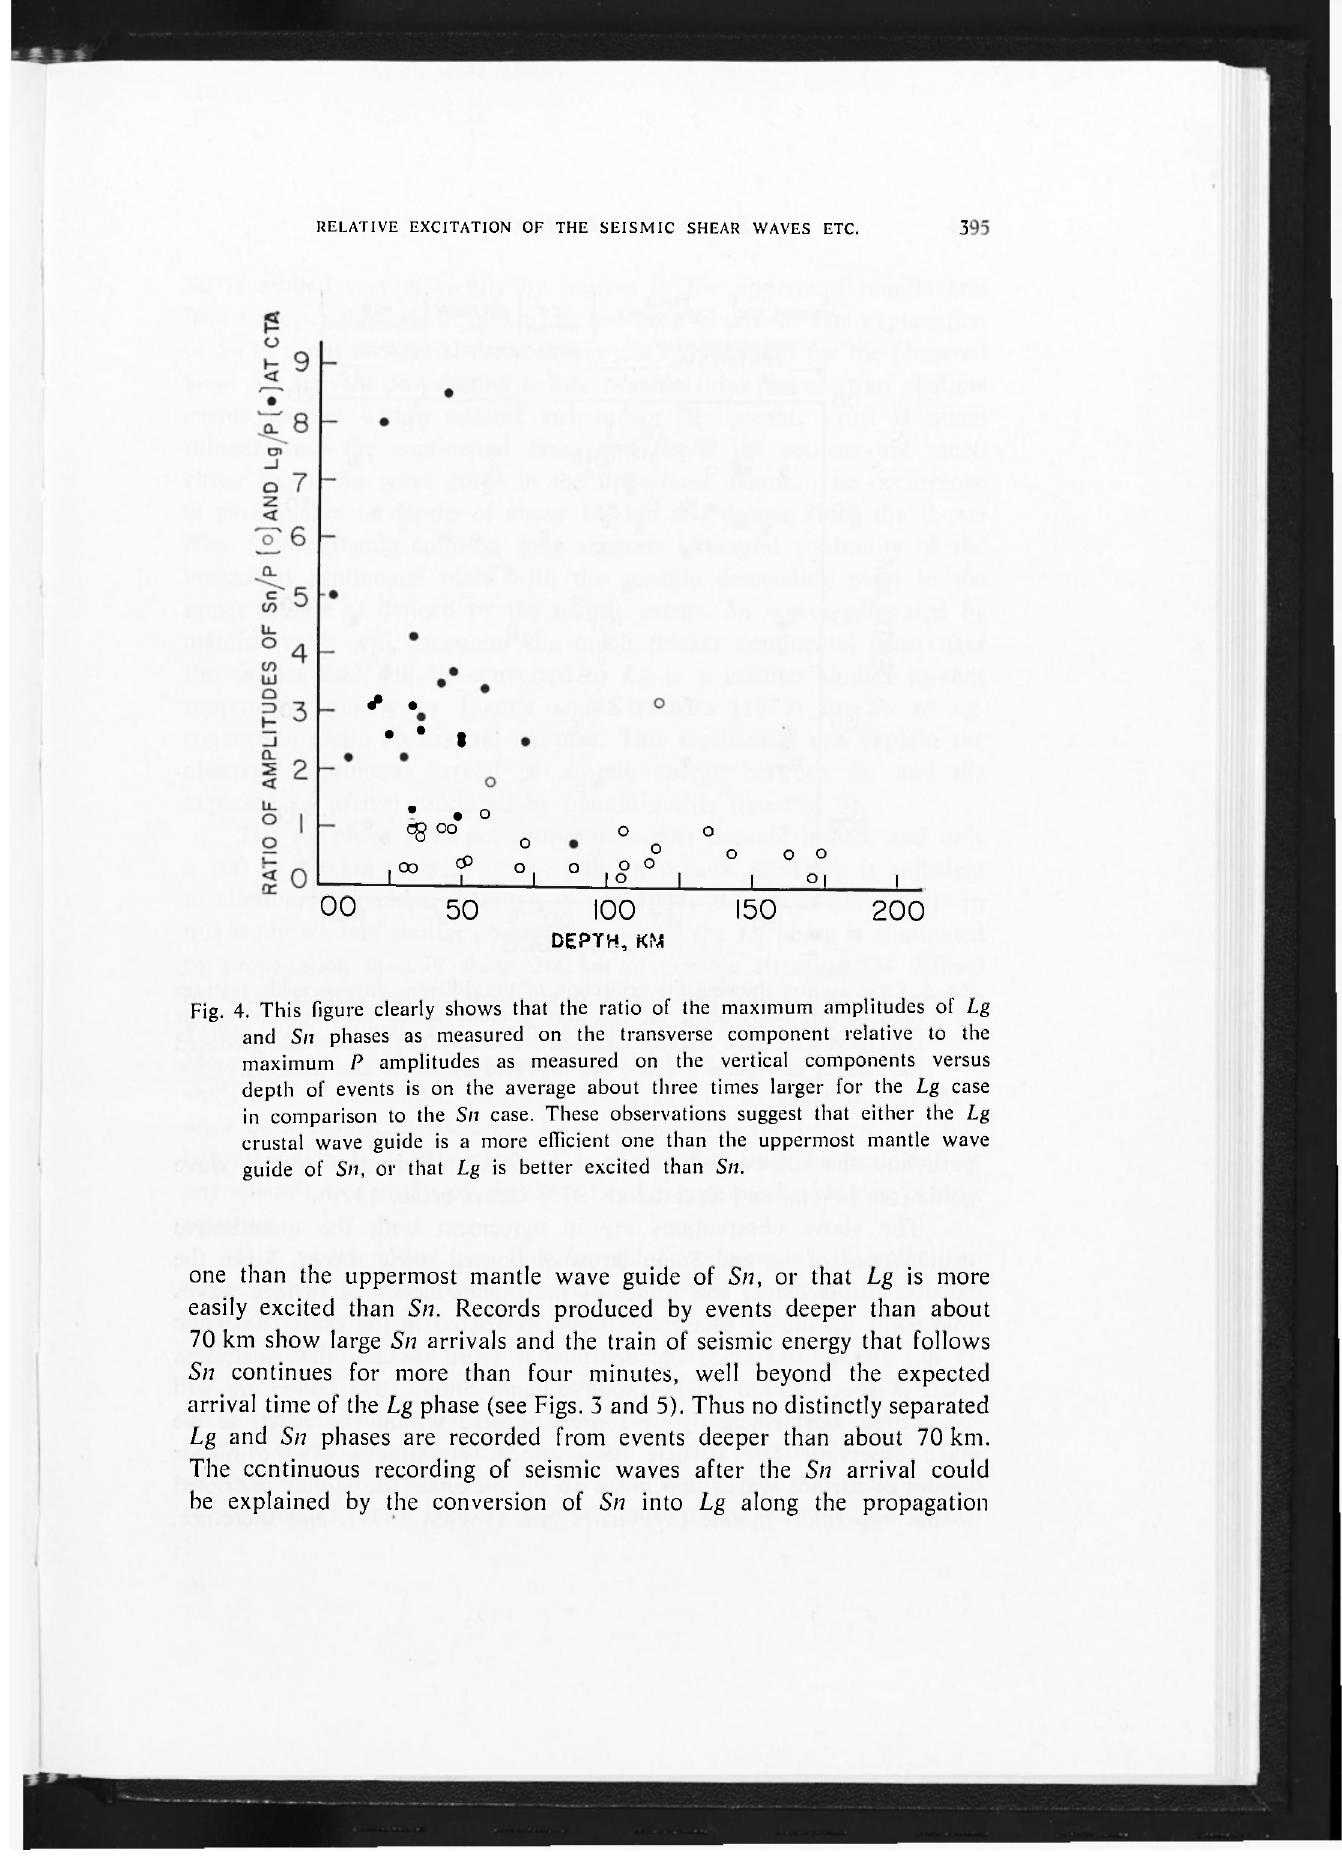
Fig. 4. This figure clearly shows that the ratio of the maximum amplitudes of Lg and Sn phases as measured on the transverse component relative to the maximum P amplitudes as measured on the vertical components versus depth of events is on the average about three times larger for the Lg case in comparison to the Sn case. These observations suggest that either the Lg crustal wave guide is a more efficient one than the uppermost mantle wave guide of Sn, or that Lg is better excited than